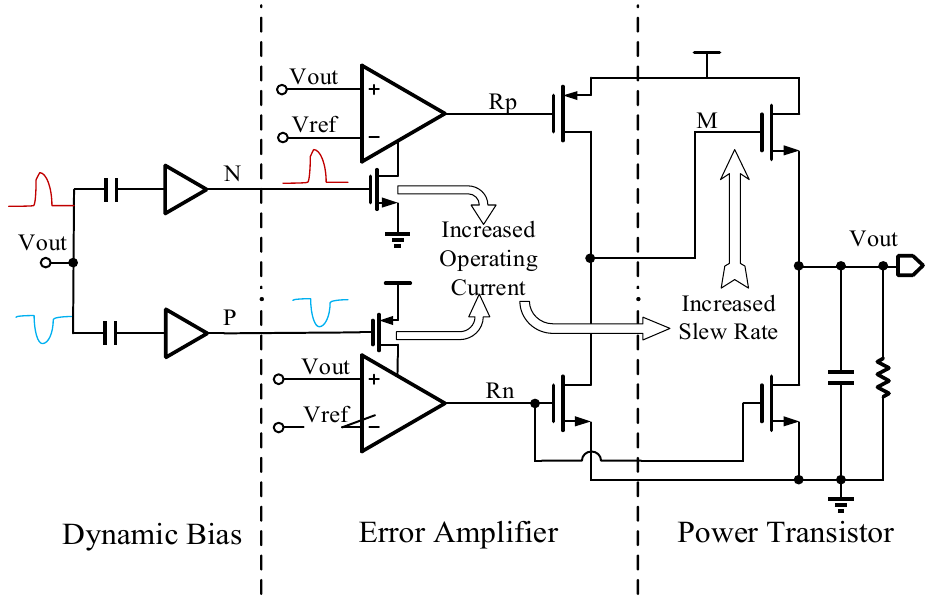
Figure 1. Basic Structure of the proposed LDO.